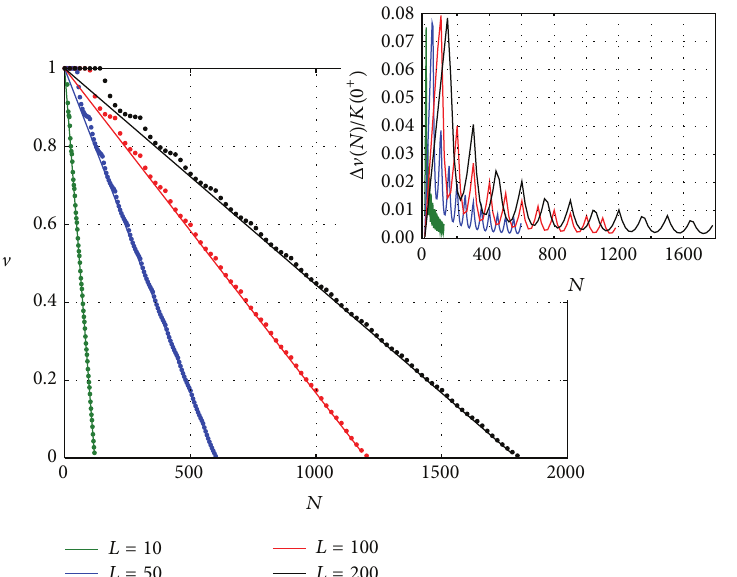
Figure 5: Speed diagrams (20) (discrete model, dots) and (21) (continuous model, solid lines) obtained, for different values of 𝐿 , with V d = 1 , 𝐾(𝑧) = (1/2)𝑧(1 − 𝑧) . The graph in the upper-right box shows the convergence to 0 of the quantity Δ V (𝑁) for 𝑁 → ∞